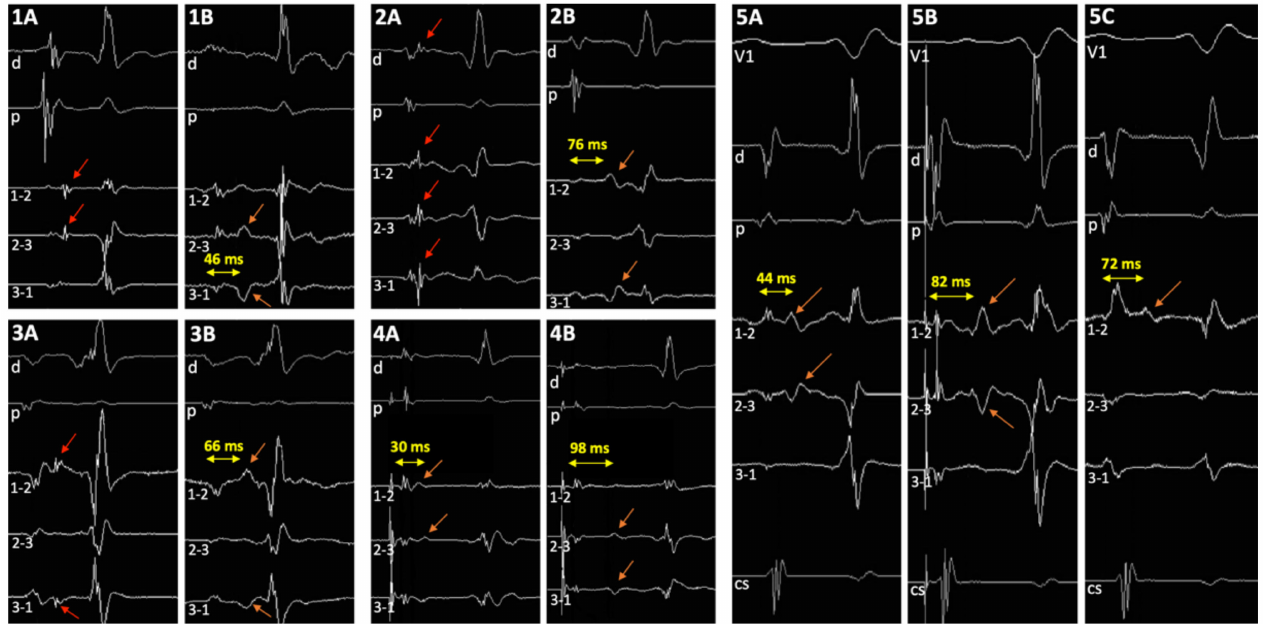
Figure 2. Tracings in 5 patients. ( 1A – 3A ) Sharp potential as described by Jackman and colleagues can be easily identified before ablation on the mini-electrodes bipolar channels, and on distal ablation bipole in 1 patient ( 2A ) (red arrows); ( 1B – 3B ) post-ablation double potentials can be visualized (orange arrows). ( 4 ) Discrete low dV/dt potential as described by Haissaguerre and colleagues before ablation ( 4A ), and post-ablation double potentials ( 4B ) (orange arrows). ( 5 ) Haissaguerre slow pathway potential before ablation in sinus rhythm ( 5A ) and during atrial pacing ( 5B ), and post- ablation double potentials ( 5C ) (orange arrows). V1: precordial surface lead V1; d and p, ablation catheter distal (1–2) and proximal (3–4) bipolar recordings, respectively; 1–2, 2–3, and 3–4, bipolar channels between corresponding